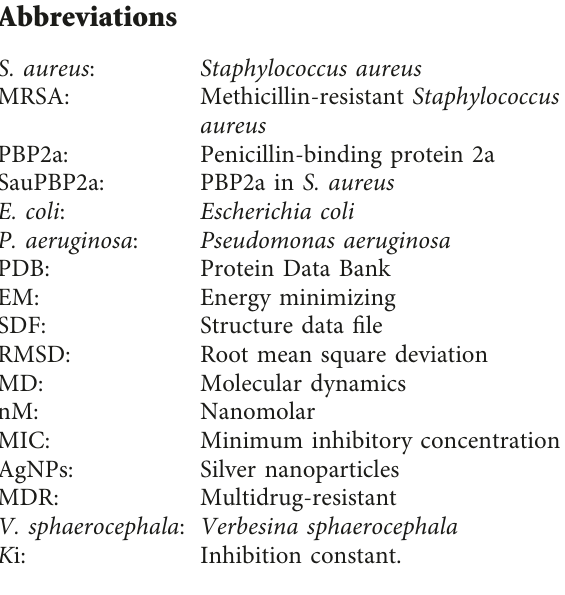
Supplementary Table 1: estimated free binding energy and inhibition constant values between 46 flavonoids, control inhibitors, and the SauPBP2a active site (PBD ID: 1MWT; chain B) achieved from the AutoDock software. ( Supple- mentary Materials